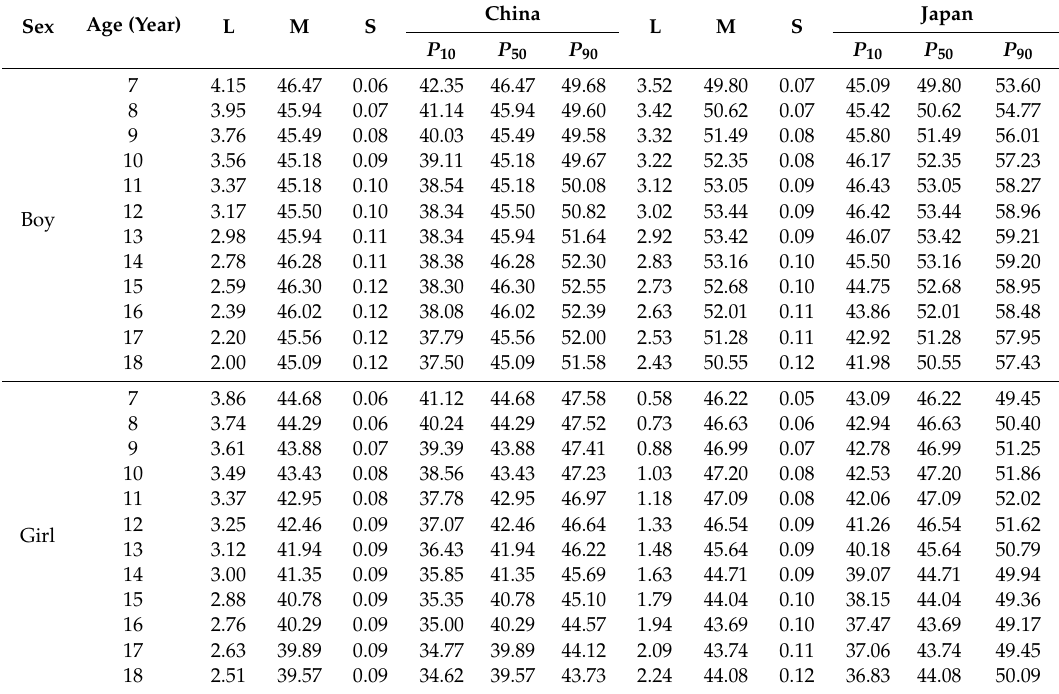
Table 5. Relative maximal oxygen uptake (VO 2max , mL / kg / min) centiles by age and sex in Chinese and Japanese children and adolescents aged 7–18